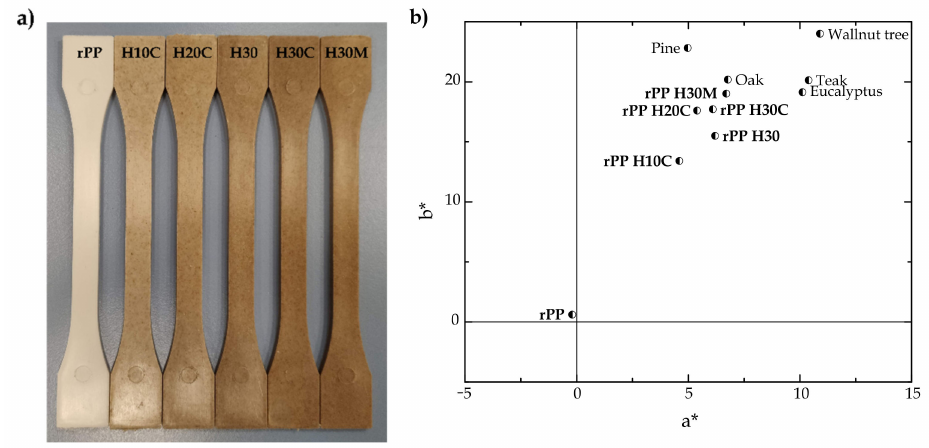
Figure 7. ( a ) Injection-molded rPP-SHF composites, ( b ) summary of CIELEAB color space ( L *, a *, b *) results of rPP-SHF